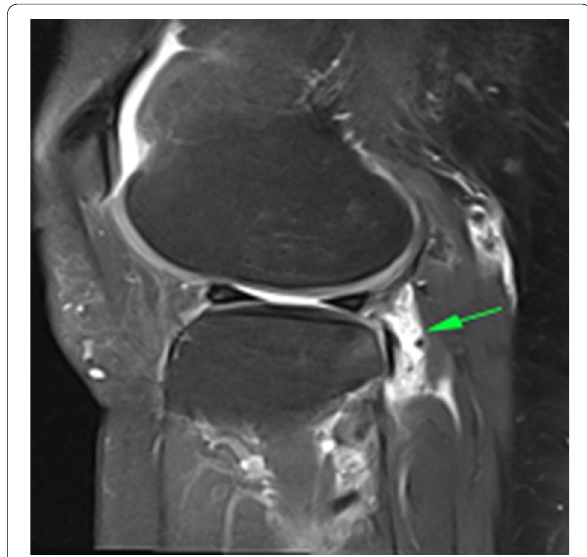
Fig. 4 A 56‑year‑old female patient suffering from instability and pain of the left knee following a recent twisting injury. Sagittal PDFS image revealing an absence of well‑defined arcuate ligament right behind the popliteus tendon, indicating possible tear